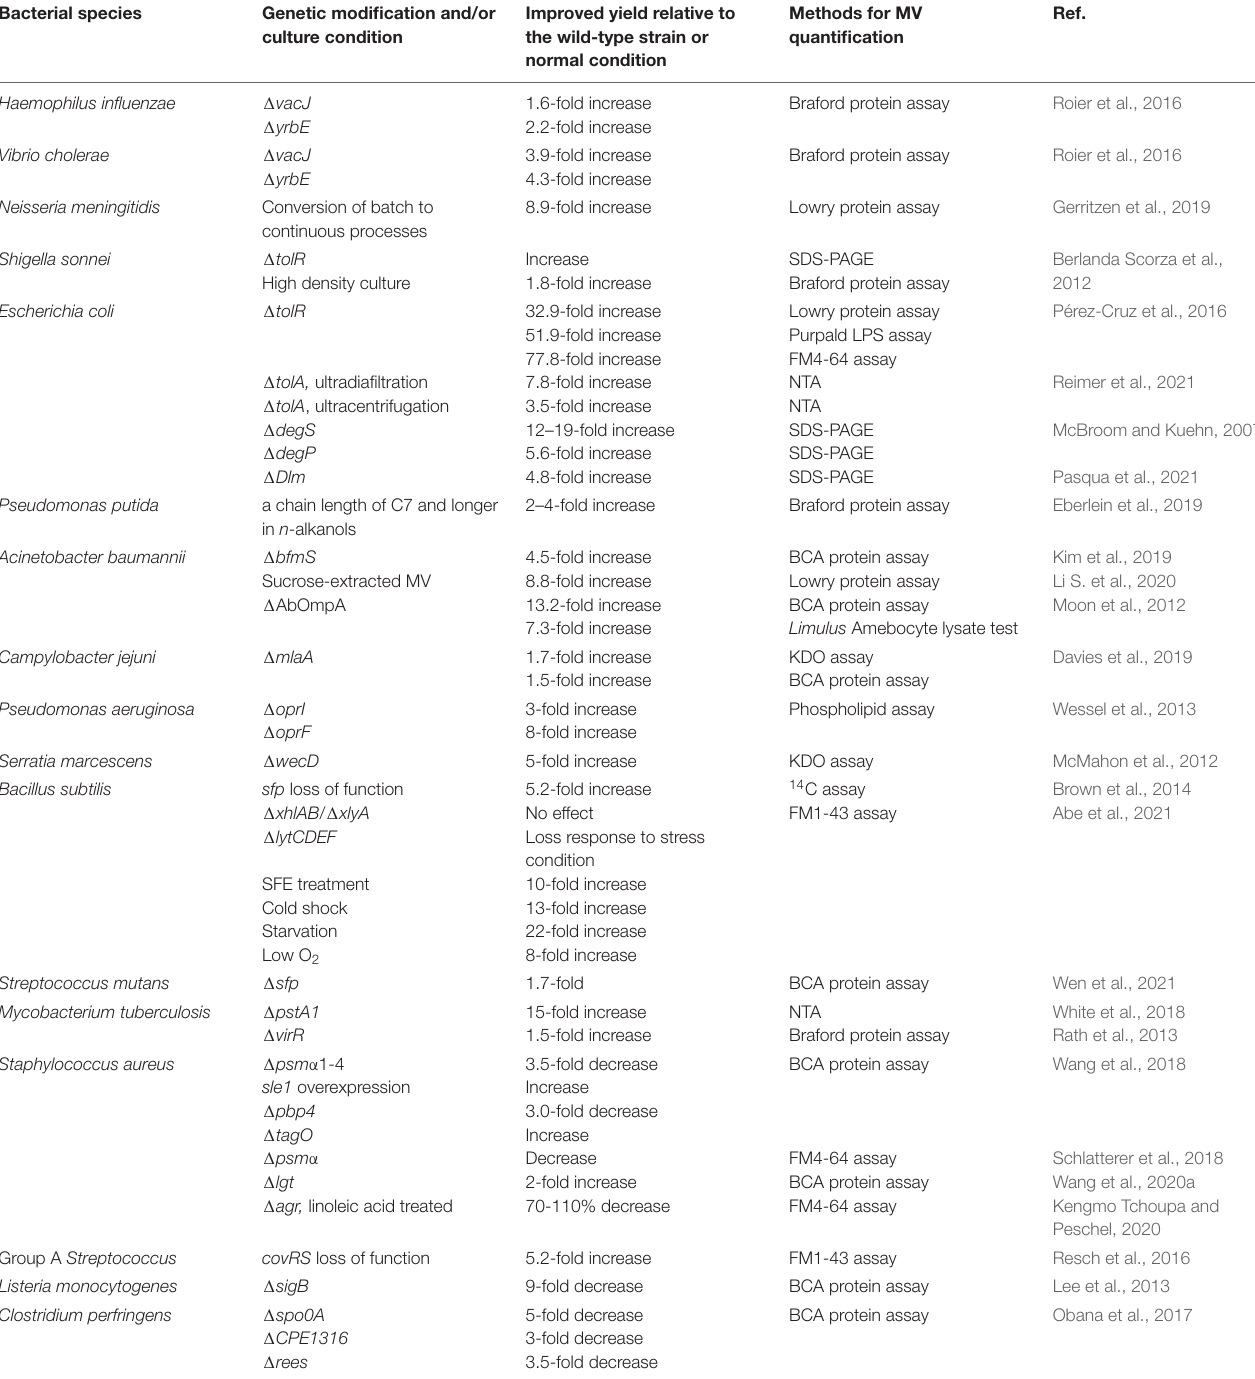
TABLE 2 | Genetic modification of target molecules that affect MV production. Bacterial species Genetic modification and/or Improved yield relative to culture condition the wild-type strain